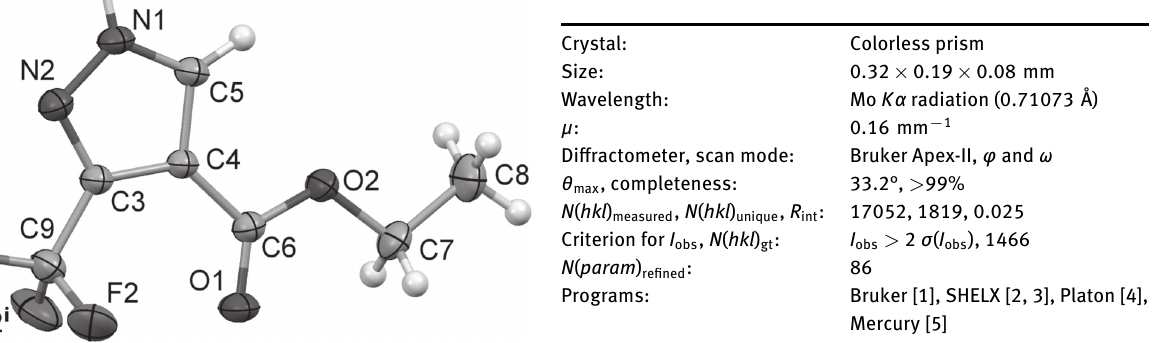
Table 1: Data collection and handling.